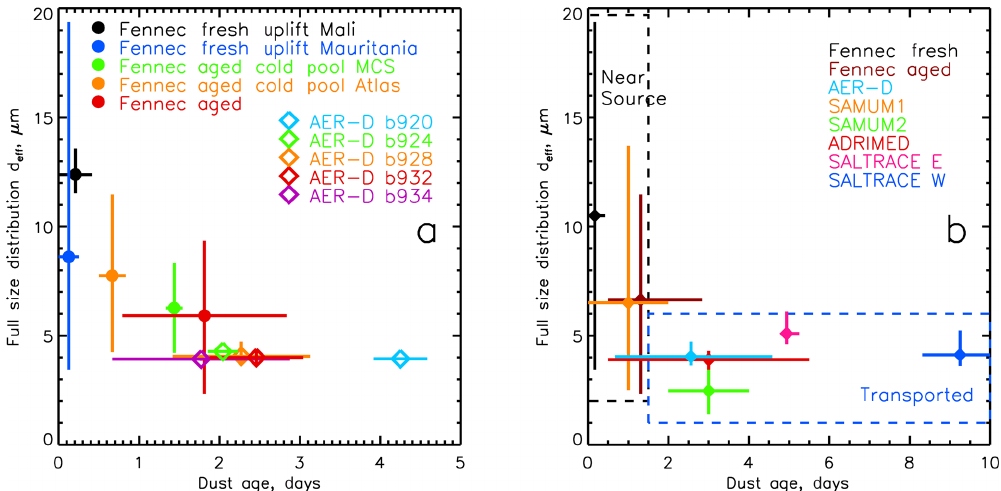
Figure 10. Aircraft observations of effective diameter for the full size distribution against dust age since uplift. (a) Fennec and AER-D: Fennec is categorized by type of dust event (see Ryder et al., 2013b), and AER-D data are separated by flight. (b) Saharan dust aircraft observations which fully measured coarse-mode size distribution up to at least 20µm in diameter; d eff is shown for the full size distribution or up to the maximum measurement diameter. Fennec-Sahara data are from Ryder et al. (2013b) and are identical to values shown in (a) , but with data merged into fresh and aged dust categories. AER-D-SAL data represent the range of flight-by-flight data shown in (a) . SAMUM1 data are from Weinzierl et al. (2009; Table 4). SAMUM2 data are from Weinzierl et al. (2011; Table 3). ADRIMED data are calculated from lognormal size distribution parameters in Denjean et al. (2016a) up to a maximum measurement size of 20µm. SALTRACE (E and W: east and west) data are new calculations based on flight segments from Weinzierl et al. (2017). Data for (b) are given in the